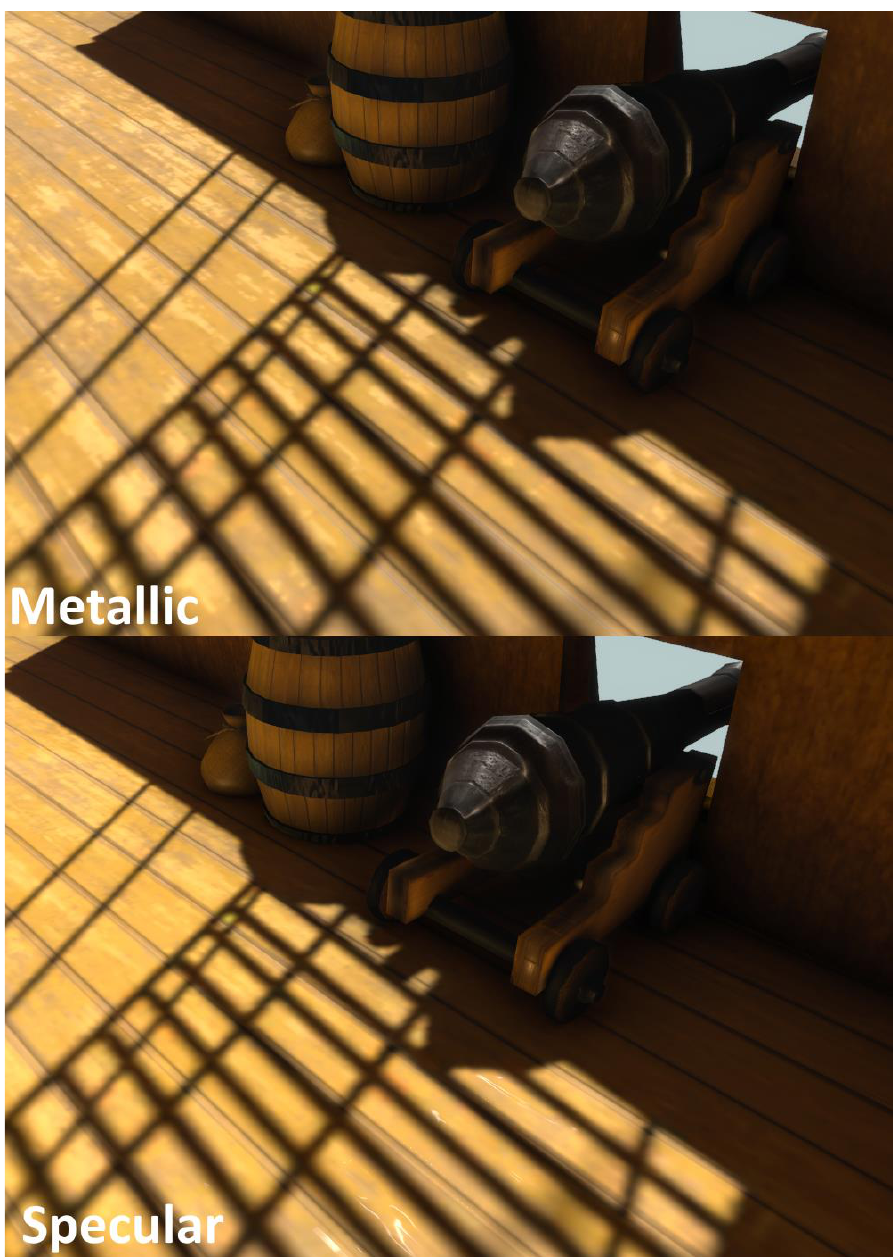
Figure 15 . Top — metallic workflow shader; bottom — specular workflow shader. Figure 15. Top—metallic workflow shader; bottom—specular workflow